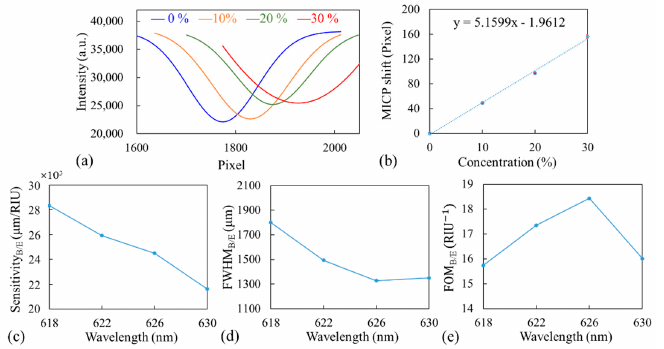
Figure 4. ( a ) Intensity distributions at different sucrose concentrations, and ( b ) shift in MICP as a function of concentration for the incident wavelength of 626 nm. ( c ) Sensitivity B/E , ( d ) FWHM B/E , and ( e ) FOM B/E of the